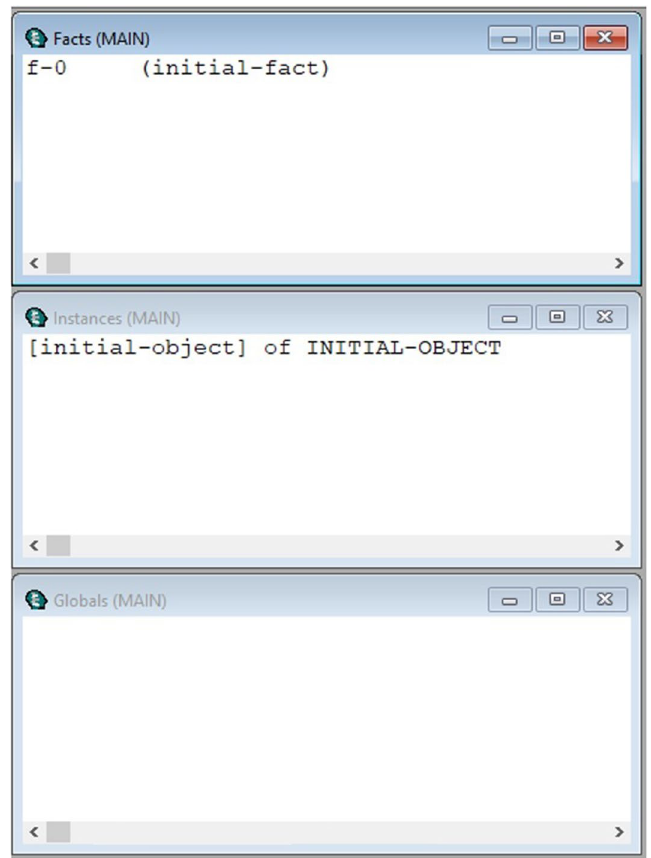
Fig. 9 Facts, instances and globals windows in CLIPS (Source: Giarratano (1996))